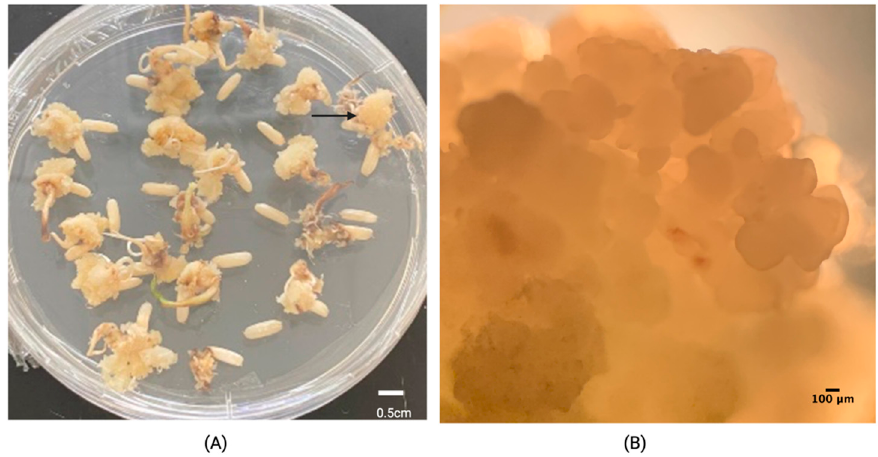
Figure 2. Calli induction of Lazarroz FL cultivar on MS medium with 2 mg L − 1 2,4-D after 15 days of culture under darkness. ( A ) Embryogenic calli obtained from the scutellum of mature zygotic embryos (arrow) ( B ) the compact and friable calli as observed under the stereoscope.